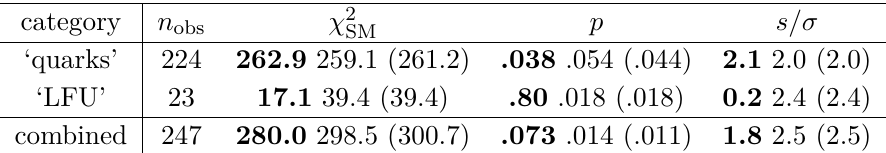
Table 1 . SM quality-of-fit as calculated by smelli2.3.2 with an updated BR ( B s → µ + µ − ) constraint (see section 4.1). Only the values in bold include the 2022 LHCb measurements of R [7] and values in parentheses are obtained without updating the BR ( B s → µ + µ − ) constraint. K ( ∗ ) n obs shows the number of observables in each category. χ 2 denotes the χ 2 statistic within each SM category, p is the p -value of the category, and s is the equivalent two-sided ‘number of σ ’ away from the central value of a univariate normal distribution. The category ‘LFU’ contains lepton flavour universality violating flavour changing observables such as R ( ∗ ) , where theoretical uncertainties K are relatively small. The ‘quarks’ category contains other flavour-changing b observables, some of which have large theoretical uncertainties (which are nevertheless taken into account in the calculation of χ 2